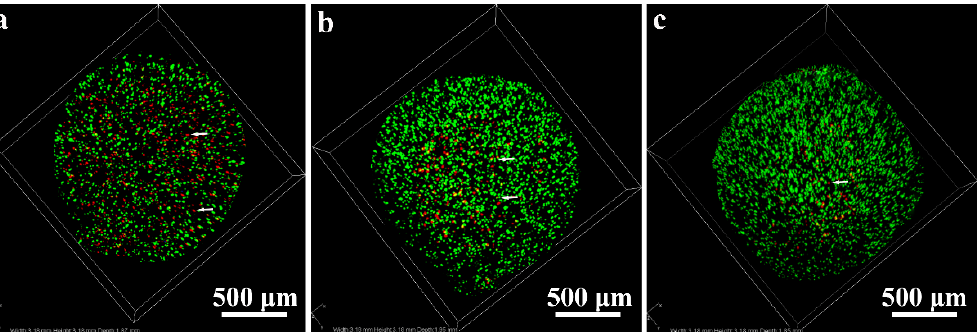
Figure 3. Confocal laser scanning microscope images of macrophages after being co-cultured with critical-sized wear particles in cell reactors for 2 d. ( a ) Alg + MPs + UHMWPE-ALN, ( b ) Alg + MPs + UHMWPE, and ( c ) Alg + MPs. White arrows indicate the dead macrophages.